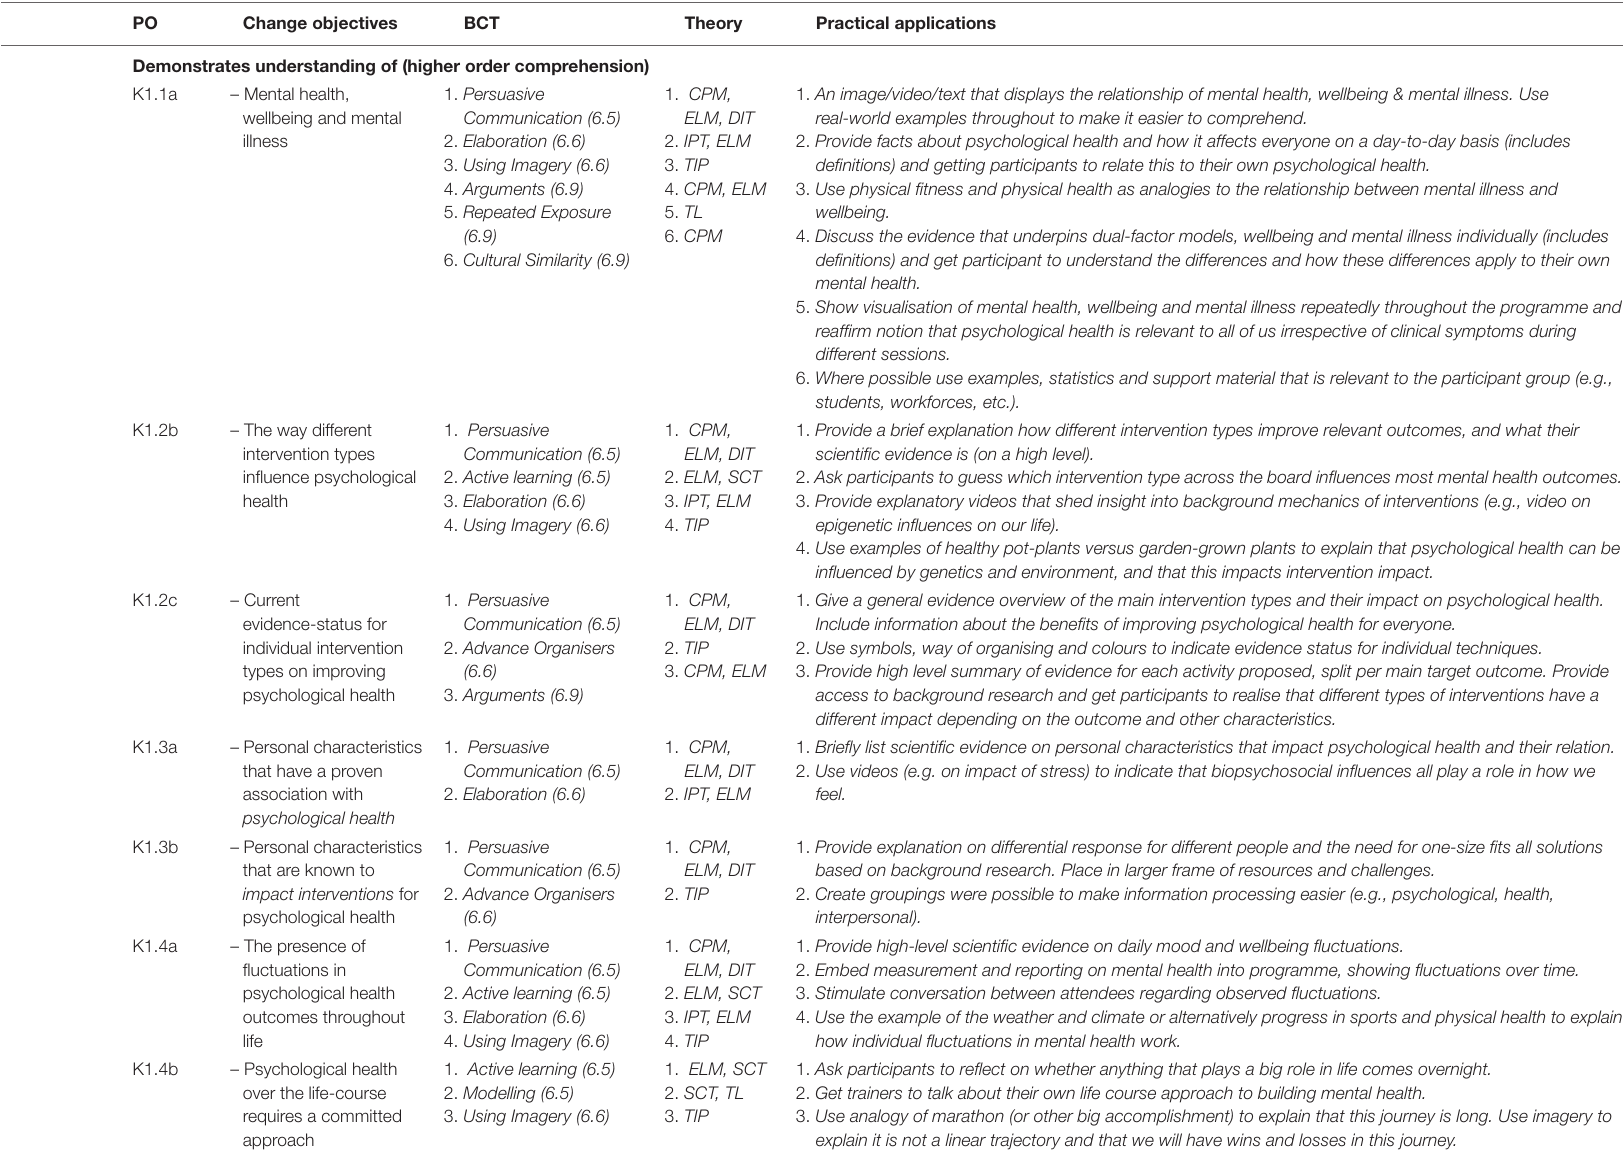
TABLE 2 | Combined table for behavioural outcome 1 (engages in regular activities that are known to increase wellbeing and mental health of the individual), behavioural outcome 2 (practices resilience activities to prepare for times of stress and adversity), and environmental outcome 1 (relationship supports individual in striving for more wellbeing and resilience). PO Change objectives BCT Theory Practical